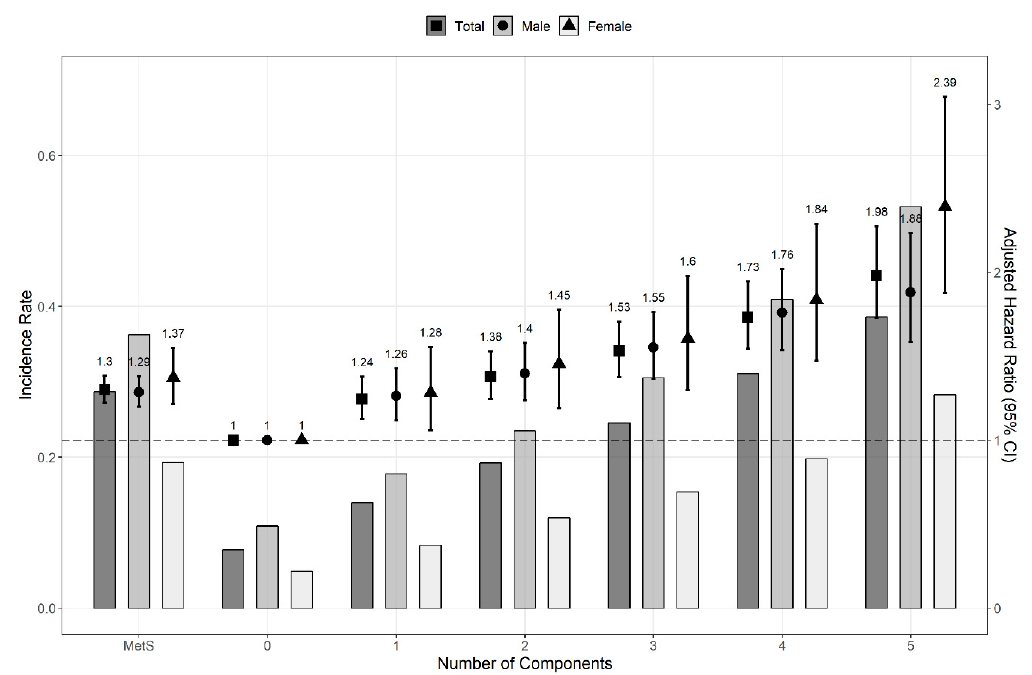
Figure 3. Hazard ratios and incidence rate for the risk of kidney cancer by numbers of MetS components (except for the first two years of follow-up). The Cox proportional hazard regression model was adjusted for age, sex, smoking status, alcohol consumption, body mass index, and regular physical exercise. When the analysis was conducted based on sex, the factor sex was excluded from the covariates. Abbreviation: CI, confidence interval; MetS, metabolic syndrome.